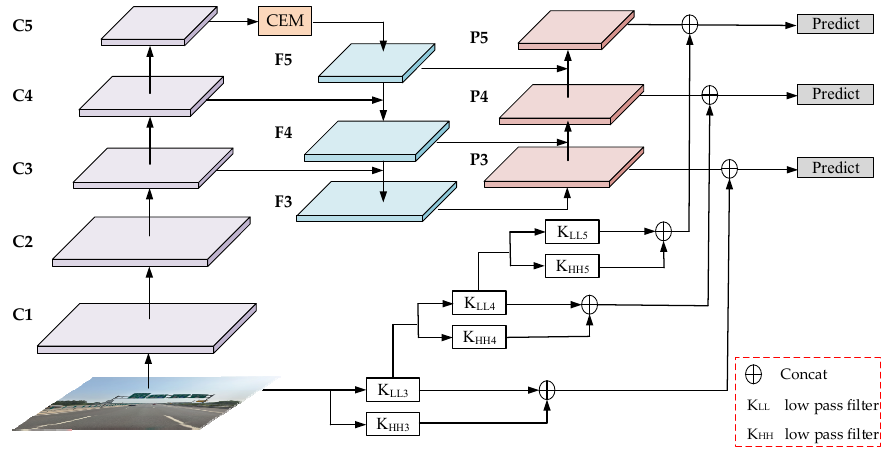
Figure 1. The overall structure of AIE ‐ YOLO network.